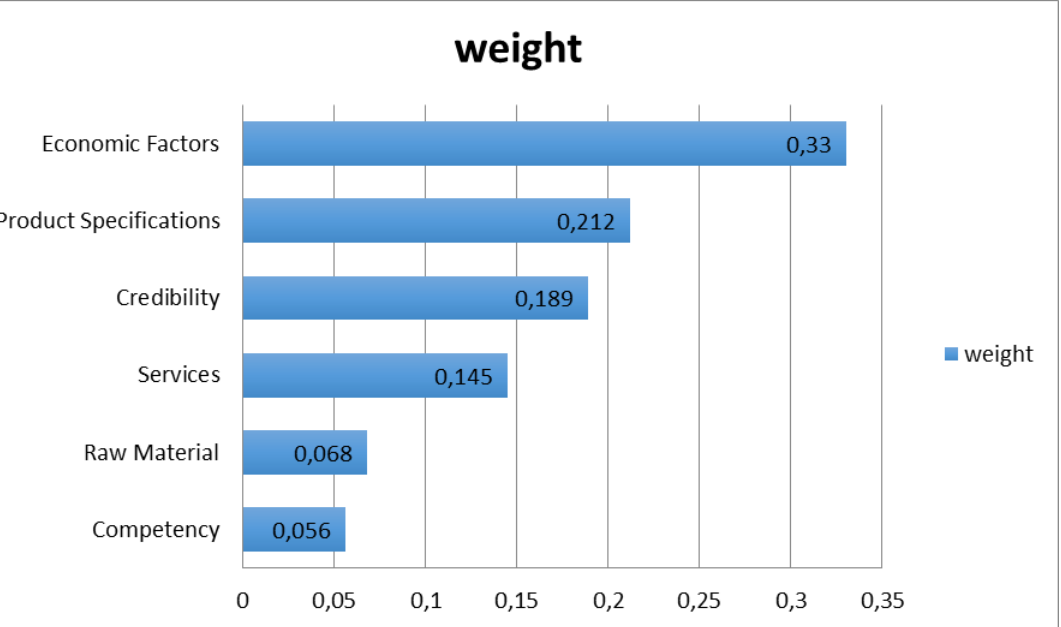
Source: research